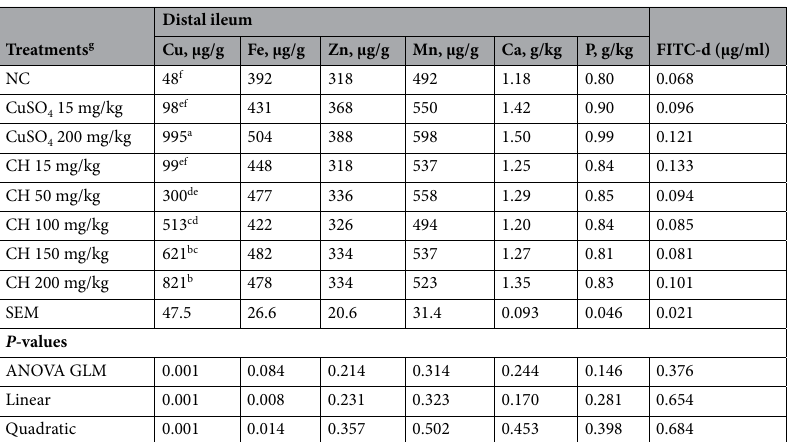
Table 7. Mineral concentration in distal ileum content at day 35 and serum FITC-d values at day 14. a–f Values in a column with no common superscripts differ significantly (P ≤ 0.05). Mean values are based on 3 birds per replicate and 6 replicates per treatment. g NC Negative control, no added Cu, CH Copper hydroxychloride (Intellibond Cu). Cu Copper, Fe Iron, Zn Zinc, Mn Manganese, Ca Calcium, P Phosphorus, FITC‑d fluorescein